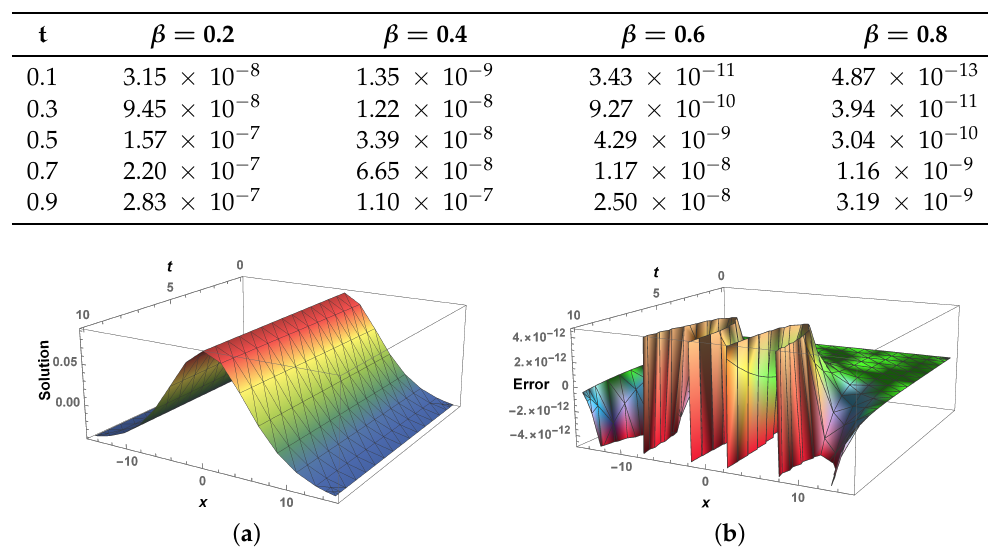
Figure 1. 3D graphical illustration of LHPM solution ( a ) and error ( b ) in Example 3 when β = 1 and k = 0.15.